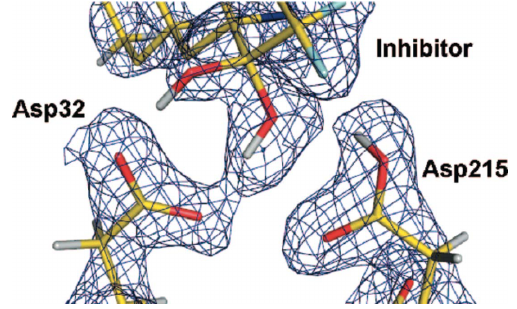
Figure 13 Nuclear density for the active site of the endothiapepsin–inhibitor complex. Asp32 is deprotonated, likely forming a low-barrier hydrogen bond with the gem -diol inhibitor, while Asp215 is protonated, acting as a hydrogen-bond donor to the inhibitor. Reprinted with permission from Coates et al. (2008), J. Am. Chem. Soc. 130 , 7235–7237. Copyright (2008) American Chemical Society.